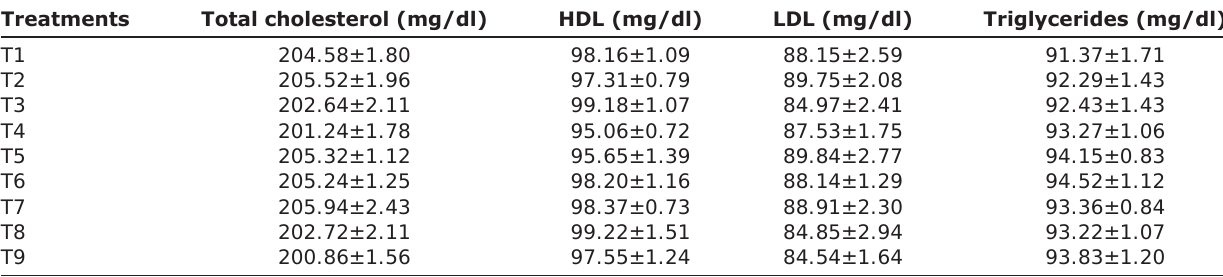
Table-5: Effect of feeding CSM on serum cholesterol in broilers. Treatments